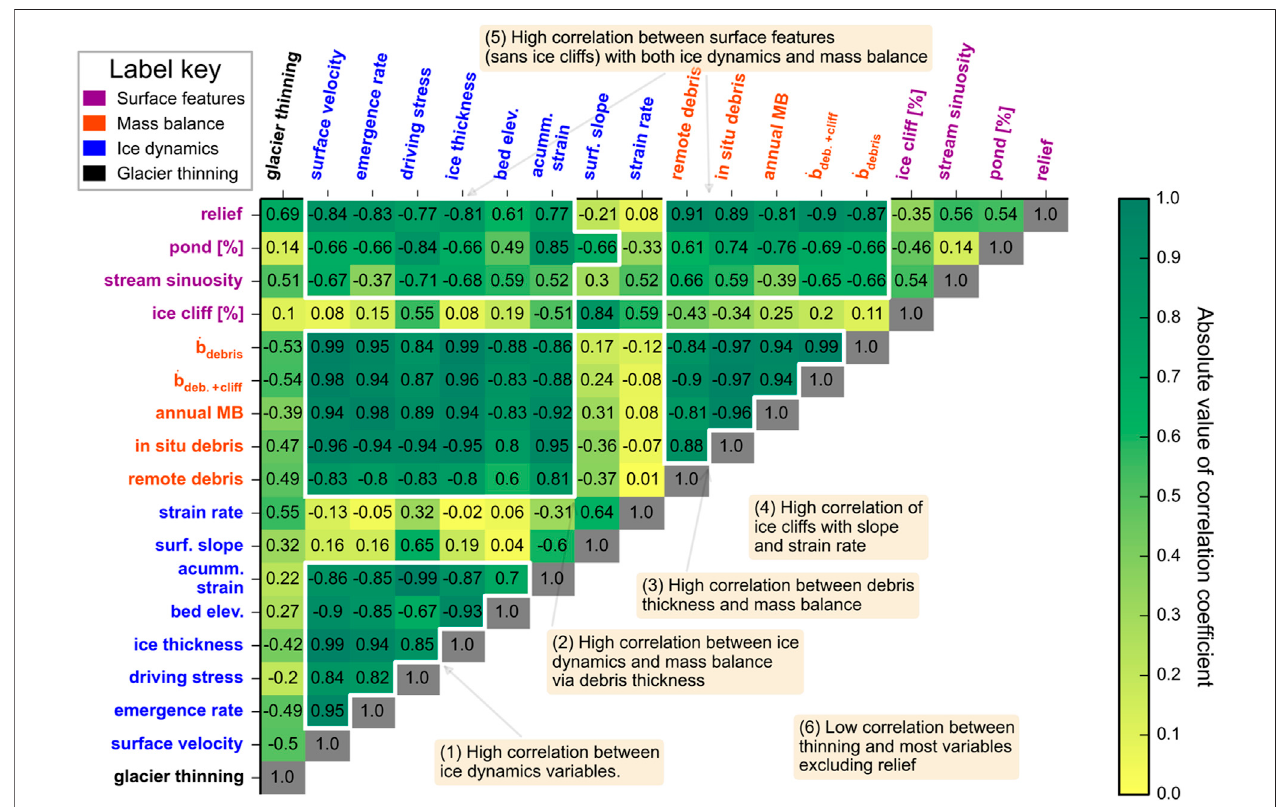
FIGURE 7 | Correlations from the modern snapshot. All datasets are derived from between 2011 and 2016. Correlations between all 18 variables are contained in thismatrix.Thegreen-yellowcolorbarshowsthemagnitudeofcorrelation.Thesignofcorrelationcanbereadfromtheblacklabelsineachcell.Cellswithhighmagnitude of correlation are outlined in white and described with annotations on the fi gure. The numbers in the annotations follow the chain of process links presented in the discussion. Relief for example can be correlated with all other properties by starting at the upper left and looking across the row to the relief label in the upper right. Pond(%)canbecorrelatedwithallothervariablesbystartingwiththeupperleftlabelandcontinuingacrosstherowuntilthelastcellandthenlookingverticallytoseethe correlationbetweenpond(%)andrelief. Notethatincreasedthinningisrepresented bypositivenumbersinthis fi gure.Thiscontrastswith Figure8 wheremorenegative surface elevation change is equivalent to more positive